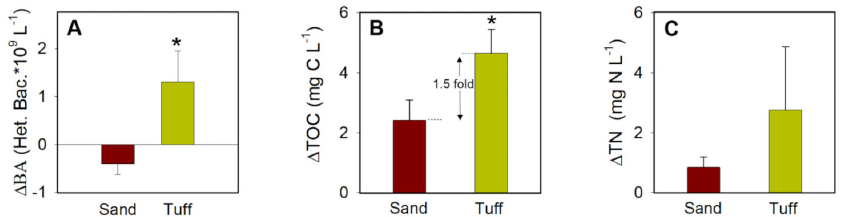
Figure 5. Overall average removal of ( A ) bacterial abundance (BA), ( B ) total organic carbon (TOC), and ( C ) total nitrogen (TN) found within the secondary e ffl uent inflow and after undergoing percolation ( ∆ ) through ~30 cm of SAT sand and maturated tu ff , respectively. Data are shown as the di ff erence of T 0 –T 48 (h) and exclude the August experiment. Asterisks indicate a statistically significant di ff erence between measurements from the sand and the maturated tu ff ( p < 0.01, n =